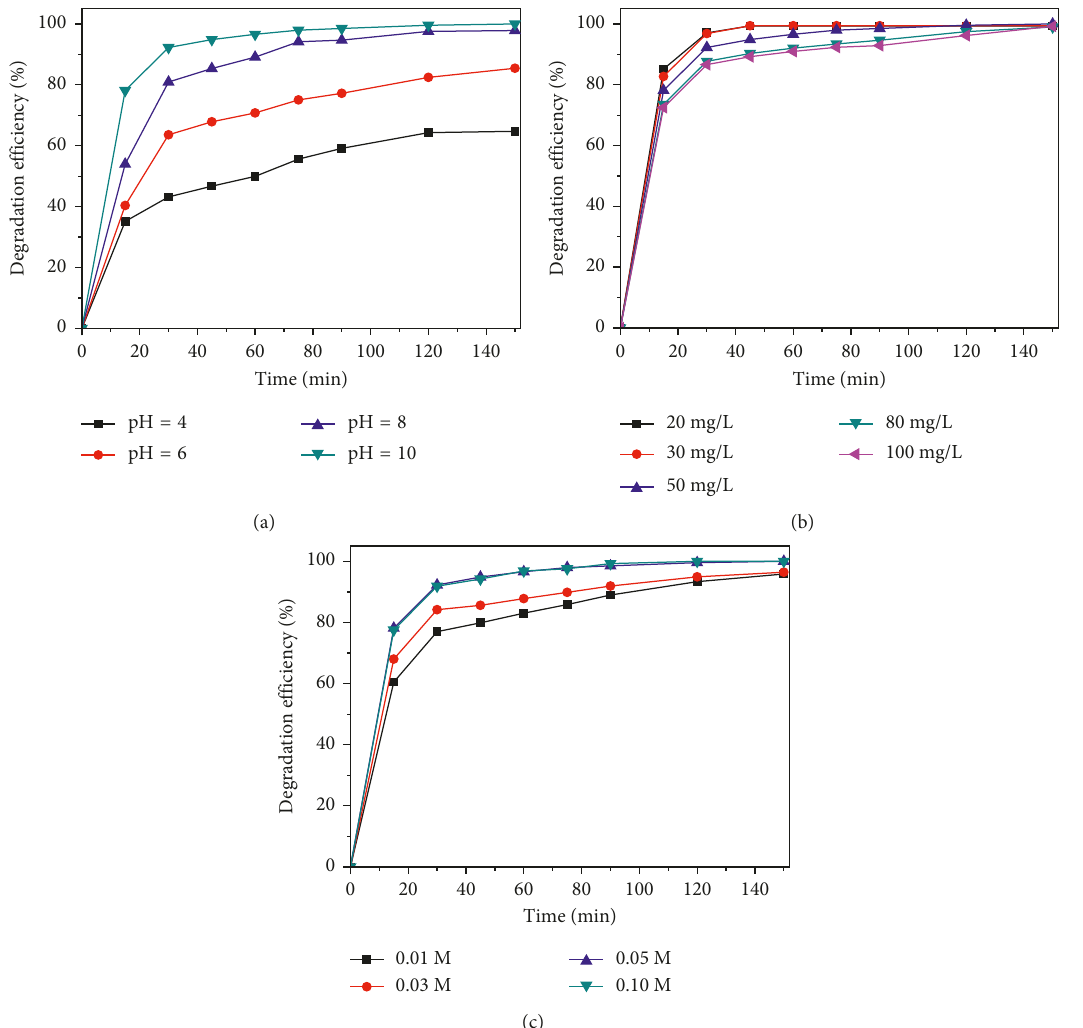
Figure 7: Effects of degradation conditions on degradation efficiency of Zn-HA sample. (a) pH. (b) Initial MB concentration. (c) Initial H 2 O 2 concentration.